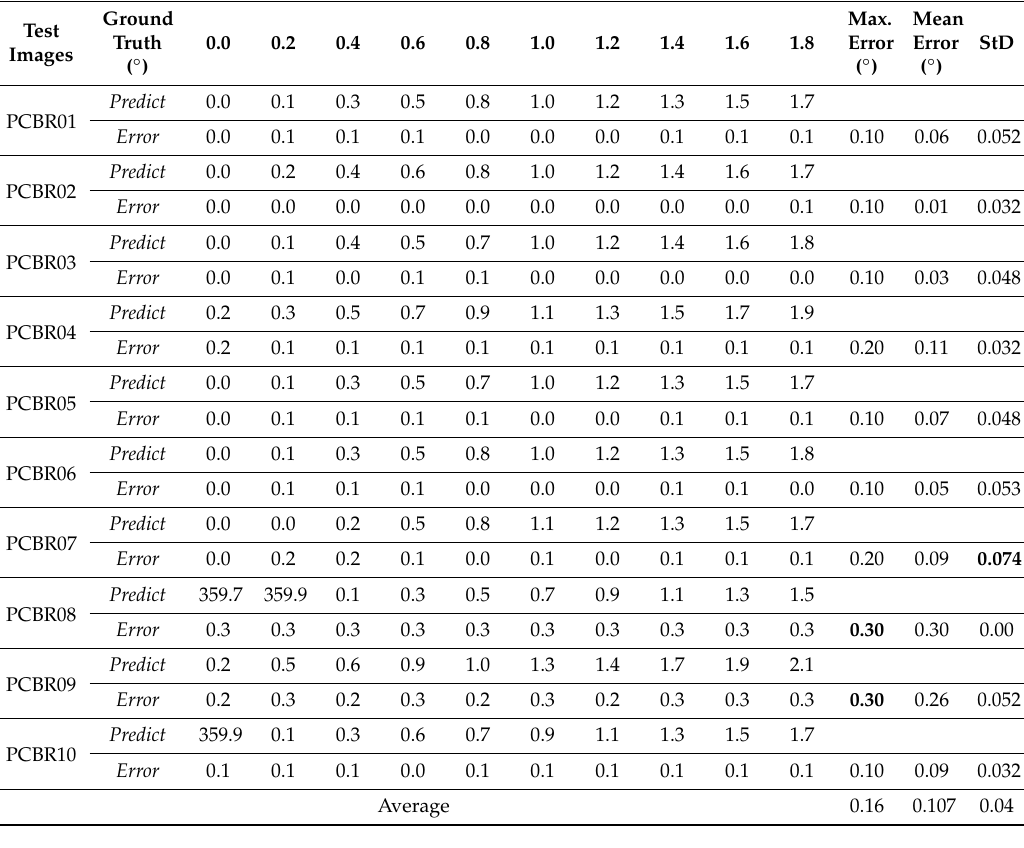
Table 4. The rotational matching results is carried out on 10 rotation PCB images (500 × 500